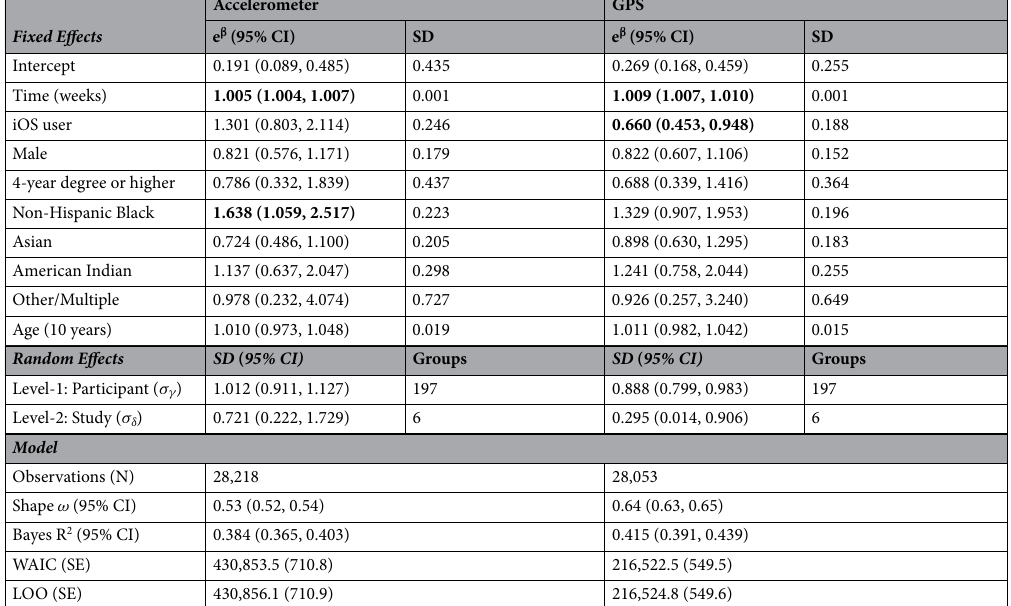
Table 2. Model results. Model estimates for all parameters for sensor non-collection rates of accelerometer (left) and GPS (right). The coefficients and 95% credible intervals (95% CI) have been exponentiated to assist interpretation. Parameters with 95% CIs that exclude 1 are in bold. The reference group for education is less than 4-year degree and that for race/ethnicity is non-Hispanic